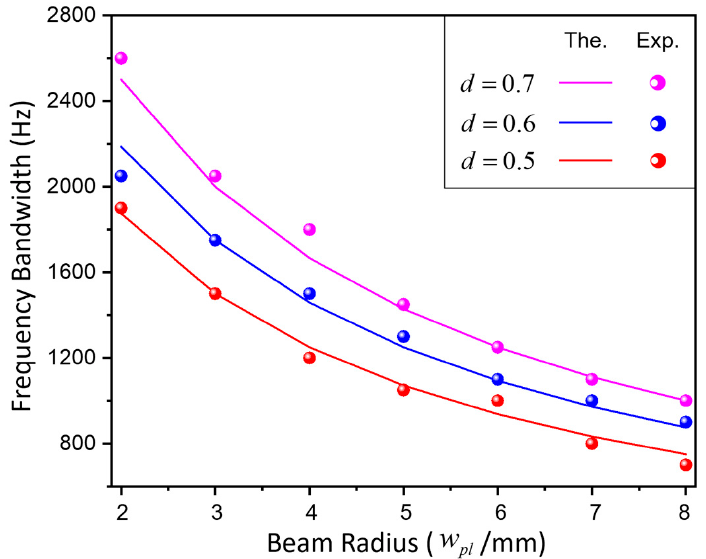
Figure 5. The variation of the RDE bandwidth with the beam size. The colored solid lines indicate the theoretical values, and the dots indicate measured values. As the beam radius increased, the RDE frequency bandwidth decreased.